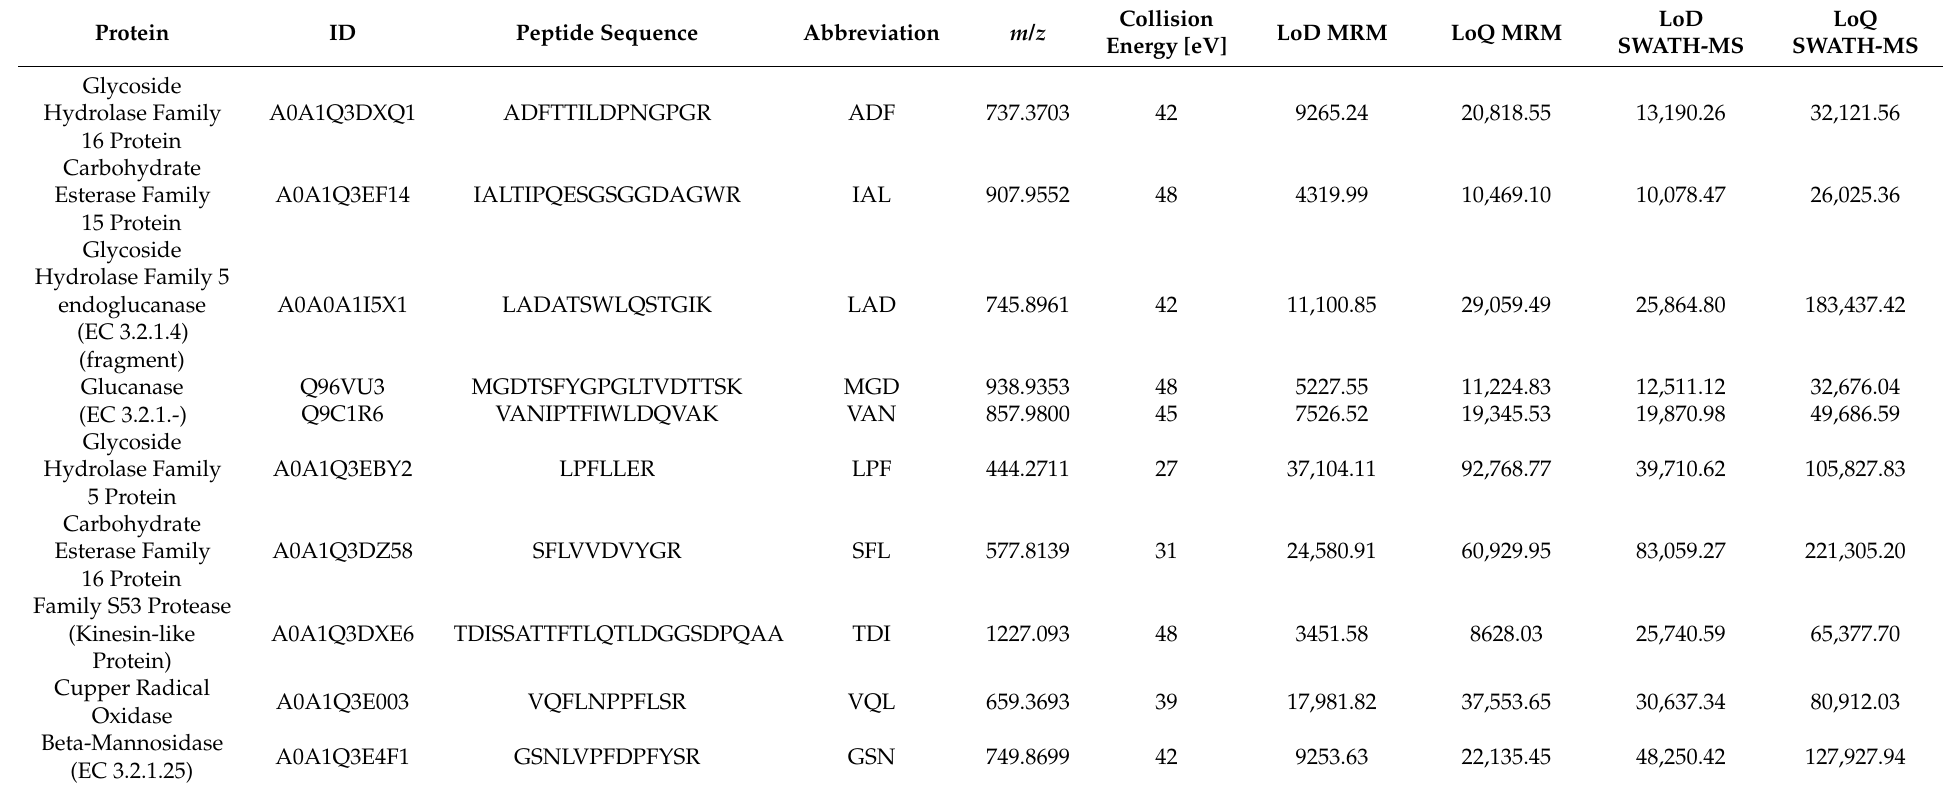
Table 2. Selected peptides of the given enzyme preparation in this study. The enzyme preparation (from the fungus L. edodes ) was added to the biogas reactor content at different concentrations and incubated at 37 ◦ C for 24 h. The resulting mass spectra were matched with the proteome of L. edodes